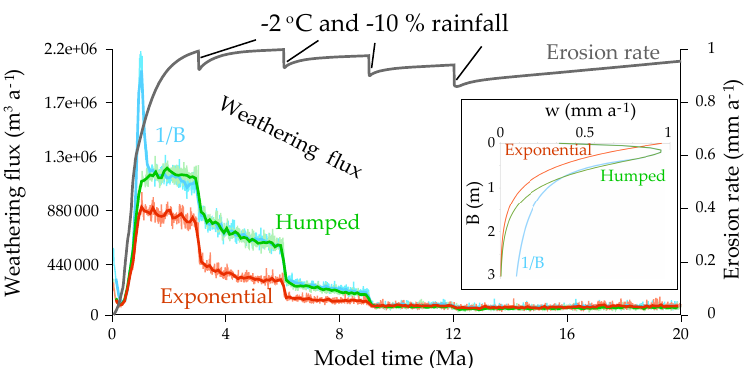
Figure 11. Effect of changing the regolith production law (inset diagram) in the OROGRAPHIC experiment with lateral erosion (Table